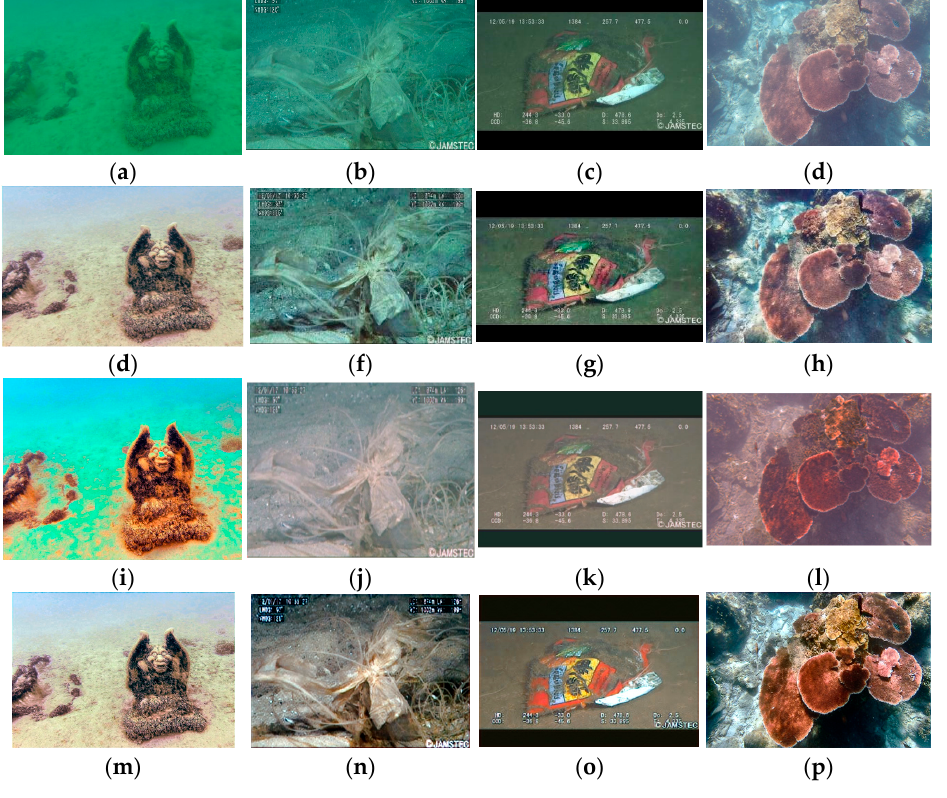
Figure 9. Results of ablation experiments on the two-stage network ( a – p ).